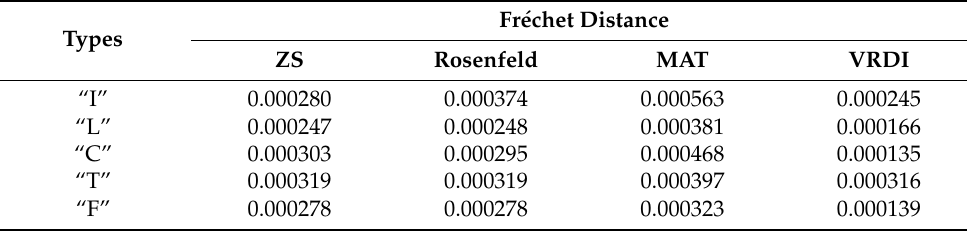
Table 1. Fr é chet distances of skeleton lines corresponding to typical buildings in Figures 18 and